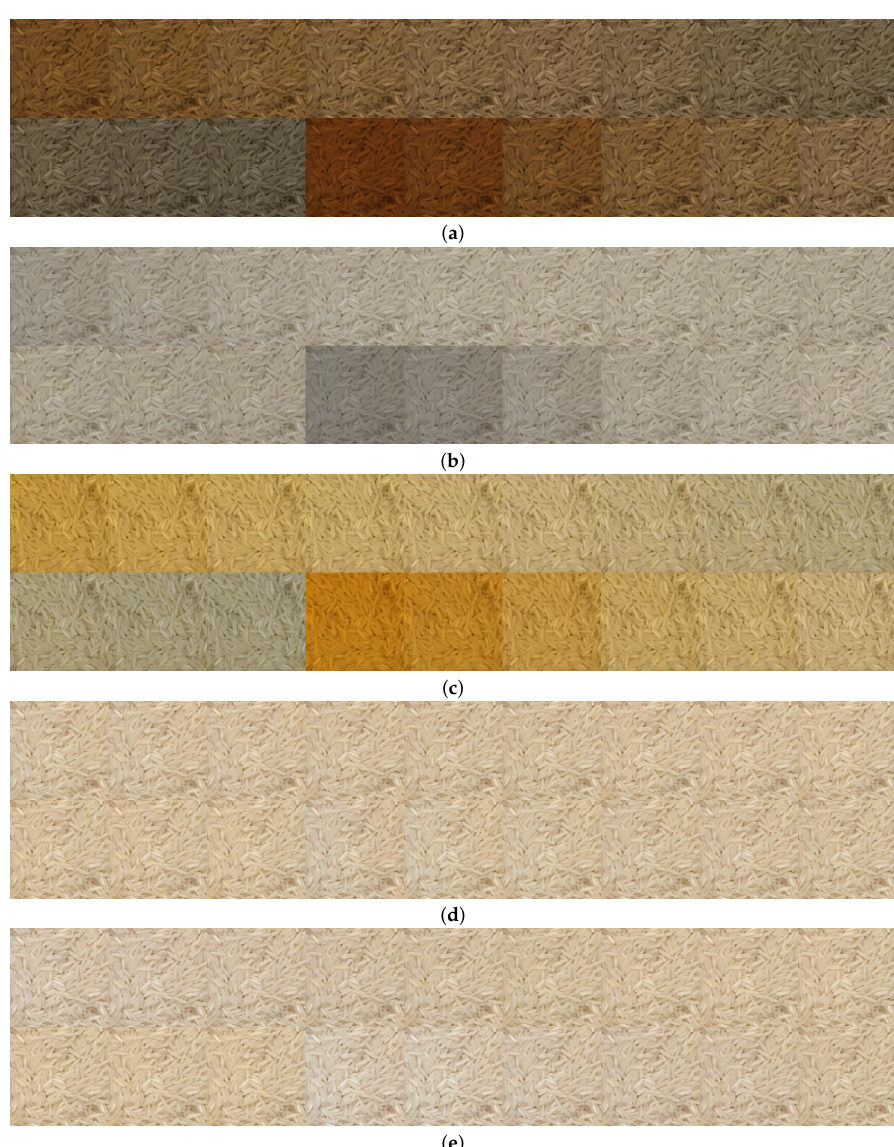
Figure 6. Example of the effect of the different color-balancing models on the “rice” texture class: device-raw ( a ); light-raw ( b ); dcraw-srgb ( c ); linear-srgb ( d ); and rooted-srgb ( e